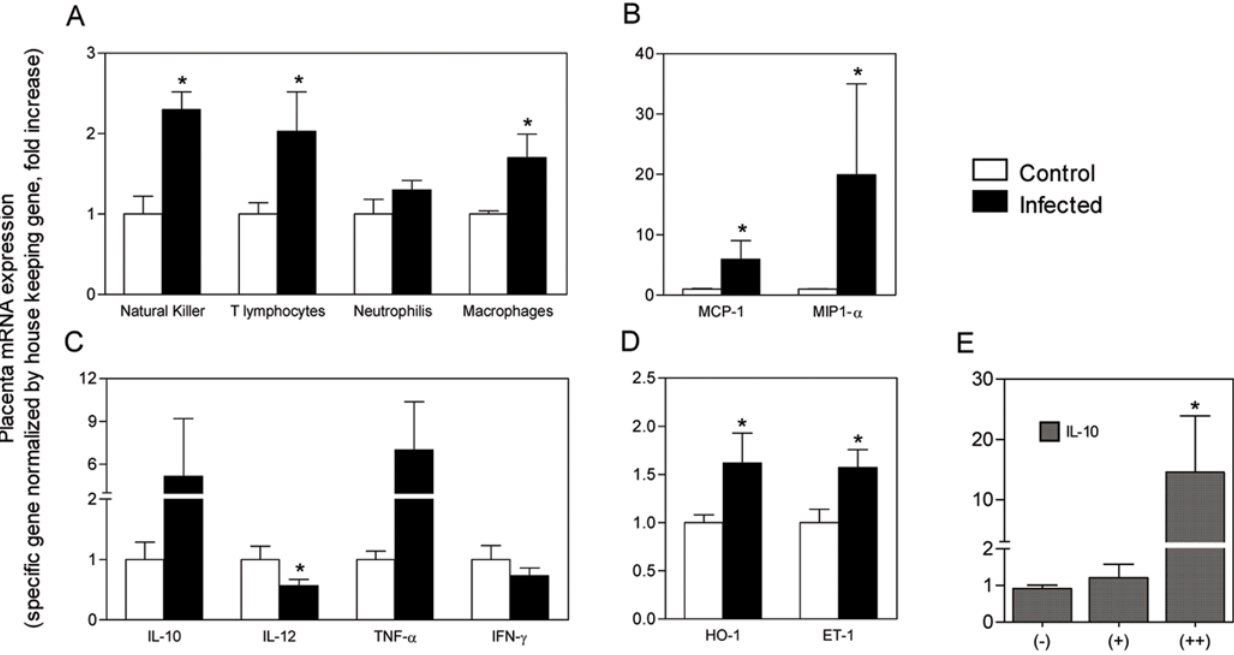
Figure 3. Placenta pathology is associated with altered gene expression of inflammation markers. qRT-PCR of placenta tissue was used to detect the expression of cell type–specific genes indicating infiltration of inflammatory cells: Klrd1 gene for Natural Killer cells, Cd3e gene for T cells, Ncf2 gene for neutrophils and Mgl2 for macrophages (A). Placental gene expression was quantified for relevant markers of monocyte/macrophage chemotaxy (B), inflammation mediators (C) and vascular stress (D). RNA expression was quantified in 15 placentas from recrudescent primiparous BALB/c females and in 8 uninfected placentas, collected on G19. In (E) placental IL10 mRNA expression was separately analyzed in 5 placentas showing moderate pathology ( + ) and 4 placentas showing severe ( ++ ) pathology. Relative quantification was obtained with normalization by b -actin for (A), (C), (D) and (E) and by GAPDH for (B). Results are plotted as fold change over the respective non-infected controls and each bar represents the mean 6 s.e.m. (*, P -value ,